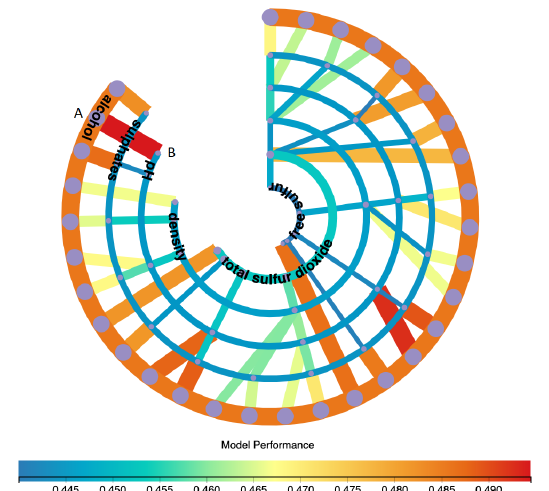
Figure 4. RadialNet of ML models based on a data set with 6 features. Reprint with permission from Jianlong Zhou, Weidong Huang and Fang Chen (2020). Copyright 2020 IEEE Pacific Visualization Symposium